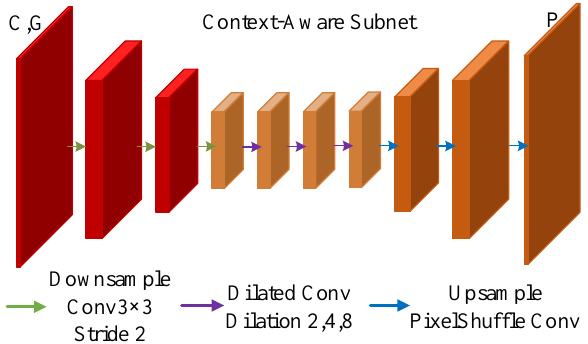
Figure 3. The framework of Context-Aware